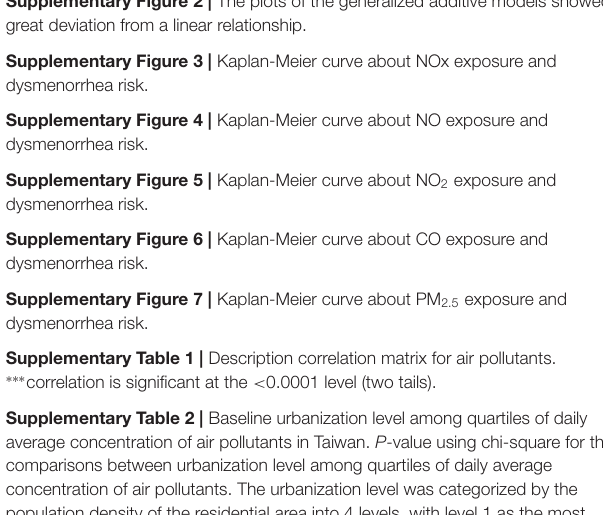
Supplementary Figure 1 | Maps of monitoring stations of air pollutants in Taiwan. Supplementary Figure 2 | The plots of the generalized additive models showed great deviation from a linear relationship. Supplementary Figure 3 | Kaplan-Meier curve about NOx exposure and dysmenorrhea risk. Supplementary Figure 4 | Kaplan-Meier curve about NO exposure and dysmenorrhea risk. Supplementary Figure 5 | Kaplan-Meier curve about NO 2 exposure and dysmenorrhea risk. Supplementary Figure 6 | Kaplan-Meier curve about CO exposure and dysmenorrhea risk. Supplementary Figure 7 | Kaplan-Meier curve about PM 2.5 exposure and dysmenorrhea risk. Supplementary Table 1 | Description correlation matrix for air pollutants. ∗∗∗ correlation is significant at the < 0.0001 level (two tails). Supplementary Table 2 | Baseline urbanization level among quartiles of daily average concentration of air pollutants in Taiwan. P -value using chi-square for the comparisons between urbanization level among quartiles of daily average concentration of air pollutants. The urbanization level was categorized by the population density of the residential area into 4 levels, with level 1 as the most urbanized and level 4 as the last urbanized. The daily average air pollutant concentrations were categorized based on quartiles for each air